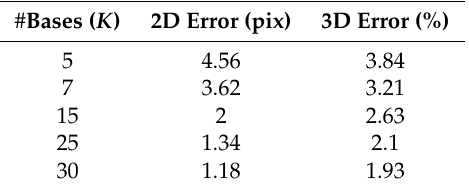
Table 1. Flag sequence error comparison with the number of bases, for K = 5, 7, 15, 25 and